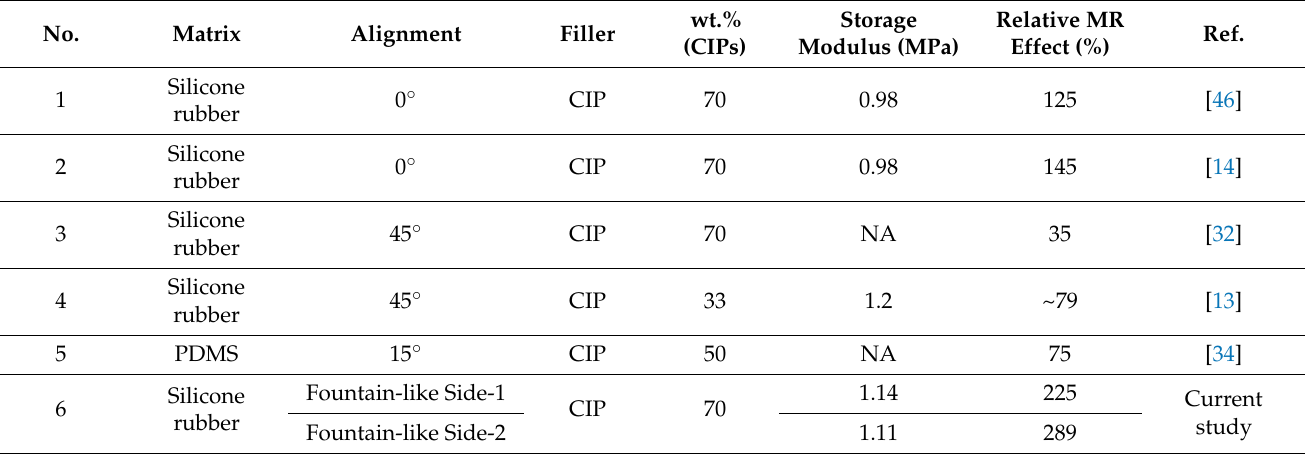
Table 6. Comparison of a particle’s alignment and MR effect of